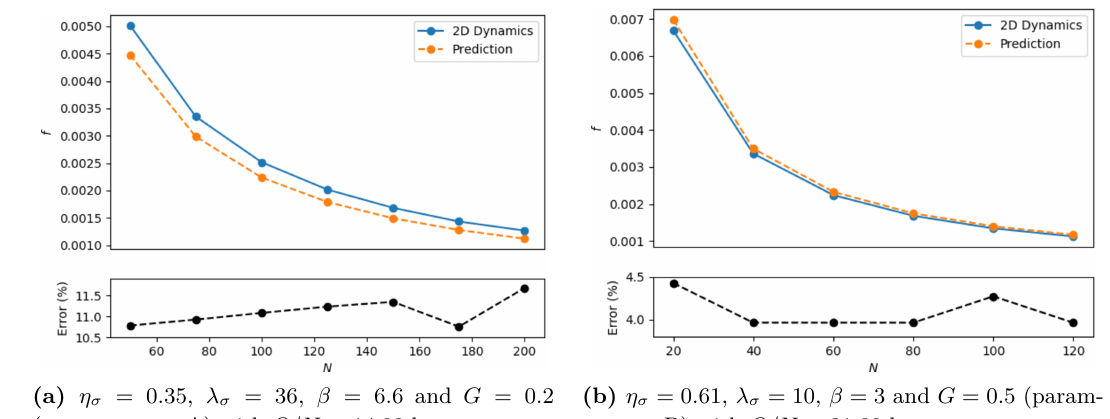
Figure 18 . A comparison of the predicted zero mode frequencies to the zero mode frequencies calculated from the radial oscillations produced when the dynamics of vortons is simulated with axial symmetry imposed. This provides a good quantitative test of the thin string approximation. We have used the frequency defined by f = Ω 2 π m m /